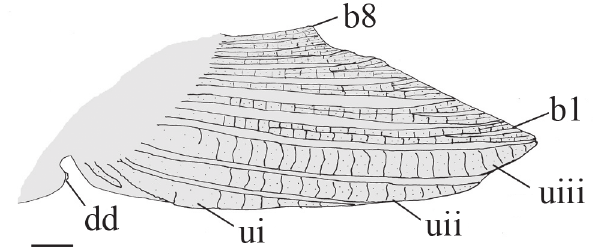
Fig. 5. Male modified anal fin of Glanidium botocudo , MNRJ 32539, paratype, 82.0 mm SL. Left side lateral